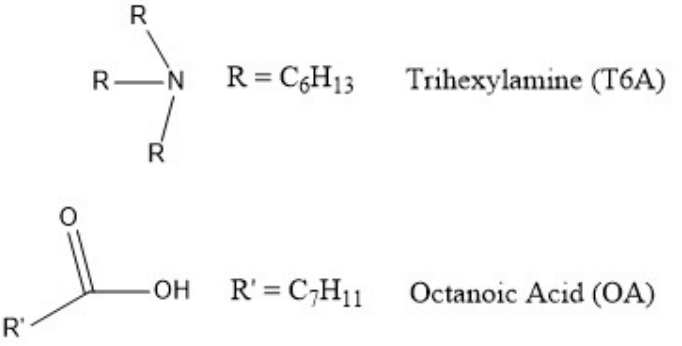
Figure 1. Organic compounds used in this study.